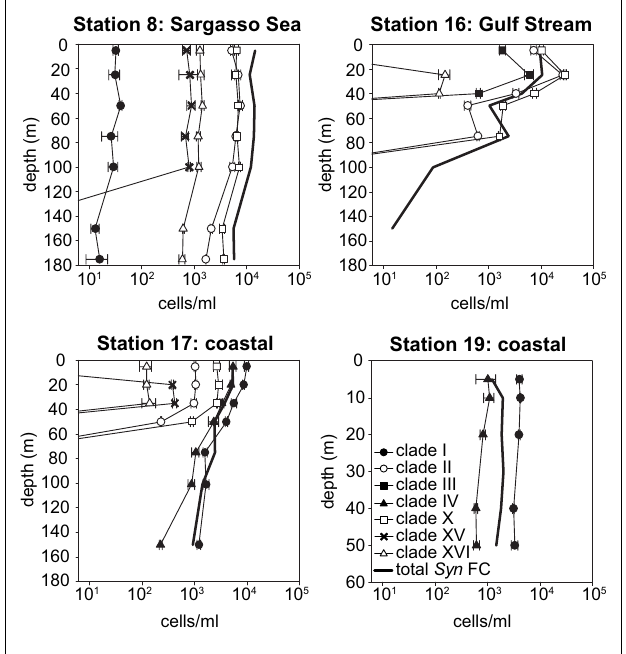
FIGURE 5 | Clade abundances determined by qPCR, and total Synechococcus concentrations determined by flow cytometry (FC). Error bars represent the standard deviation of triplicate qPCR